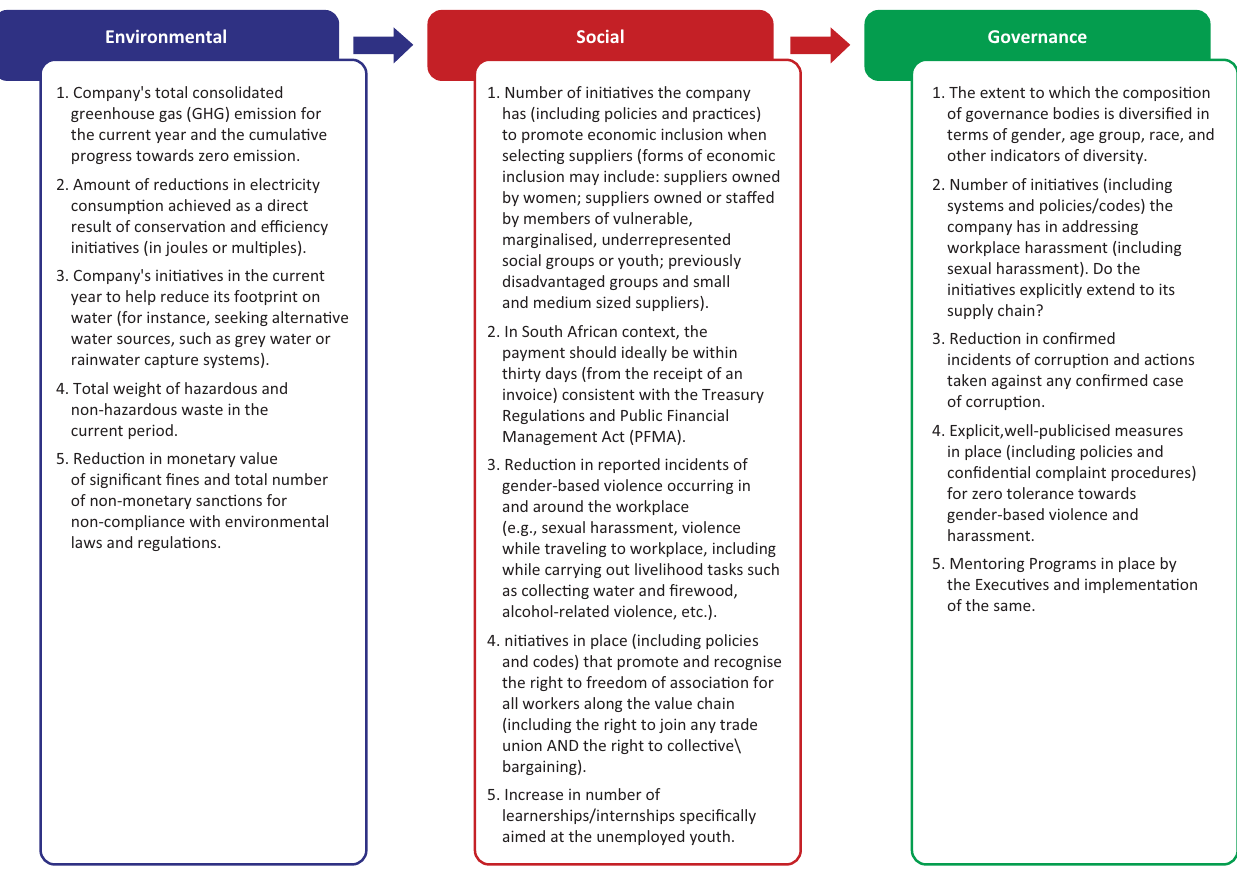
FIGURE 4: Nonfinancial performance metrics for determining executive